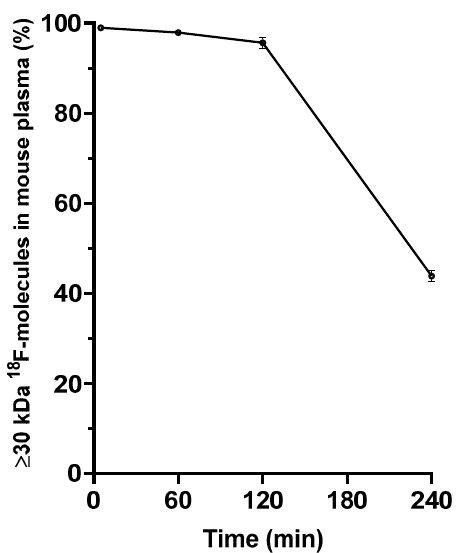
Figure 6. The ex vivo distribution (%) of ≥ 30 kDa 18 F-radiolabeled molecules in mouse plasma after intravenous injection of [ 18 F]fluoroalbumin ([ 18 F] 10 ), separated with a molecular weight cut-off filter revealed a highly stable albumin tracer until 2 h post-injection. At 240 min post-injection around 40% of radioactivity was of ≥ 30 kDa size, with almost 60% of the radioactivity being comprised of species of lower molecular weight.